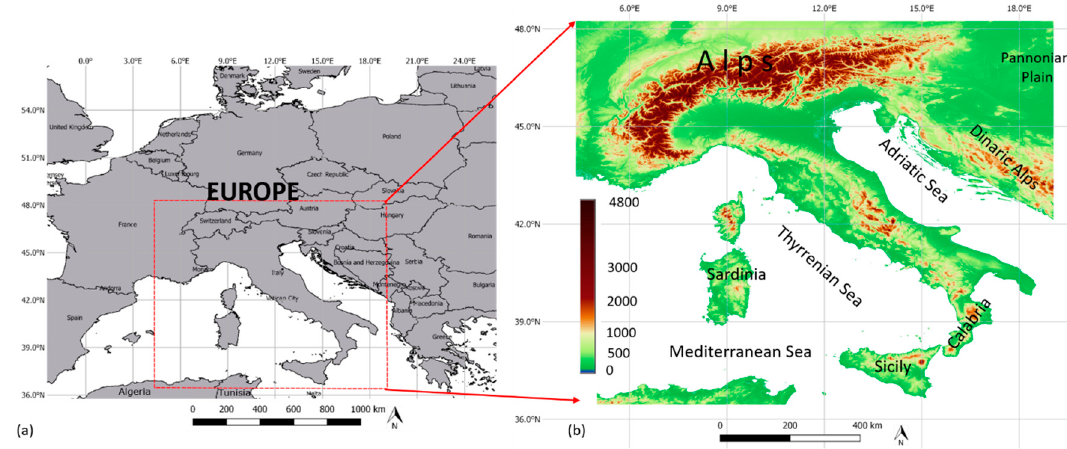
Figure 1. ( a ) Study area and ( b ) Digital Elevation Model (DEM) derived from 90 m SRTM (Shuttle Radar Topography Mission) data available at http://srtm.csi.cgiar.org/.